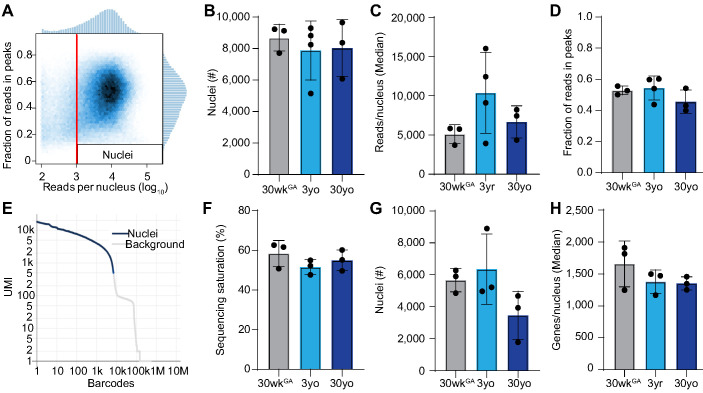
Quality control of snATAC-seq and snRNA-seq datasets.(A) Nuclei with less than 1000 uniquely mapped reads were filtered from snATAC-seq datasets. (B) Number of nuclei selected for snATAC-seq libraries after quality control and removing potential doublets. (C) Average number of reads per nucleus. (D) Fraction of reads in peak regions per dataset. (E) Representative UMI barcode distribution output from CellRanger pipeline (10x Genomics) for snRNA-seq libraries from human lungs. (F) Sequencing saturation of snRNA-seq libraries. (G) Number of nuclei selected for snRNA-seq libraries after quality control and removing potential doublets. (H) Genes detected per nucleus. All data are represented as mean ± SD.